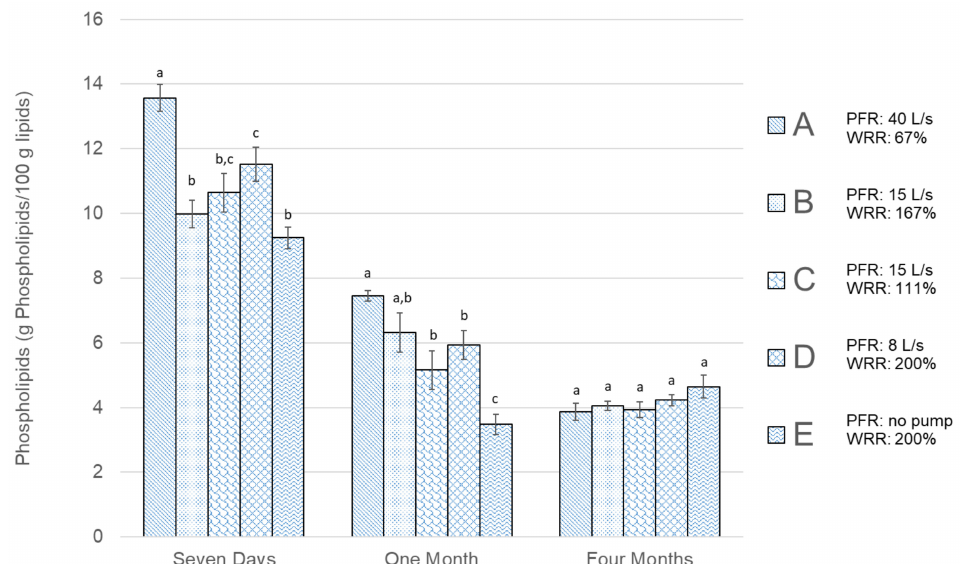
Figure 3. Phospholipids (g PL / 100 g lipids) results for all groups shown in Table 1. The error bars show the standard error of the mean values ( µ ± σ µ ), n = 6. Di ff erent letters (a, b, and c) within storage times represent significant di ff erences between experimental groups ( p <